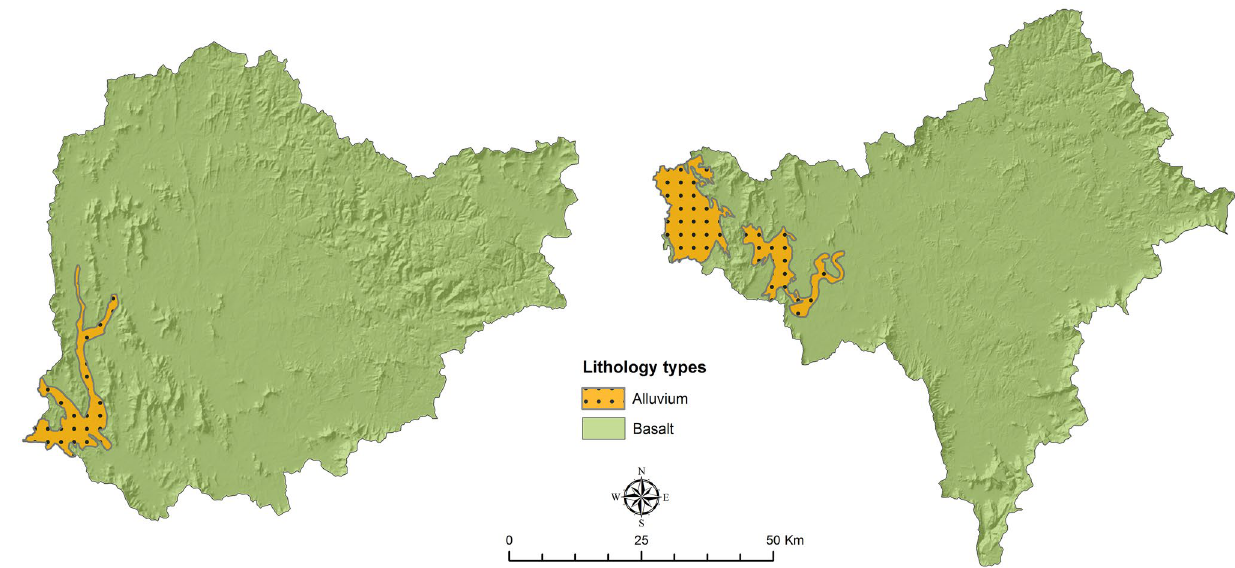
Fig. 2 Maps are showing lithological characteristics of Vaitarna and Ulhas